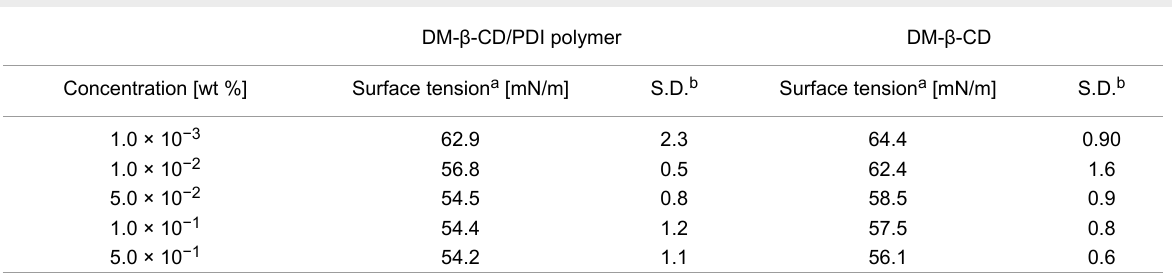
Table 1: Surface tensions of aqueous solutions of DM- β -CD/PDI nanogels and DM- β -CD at different